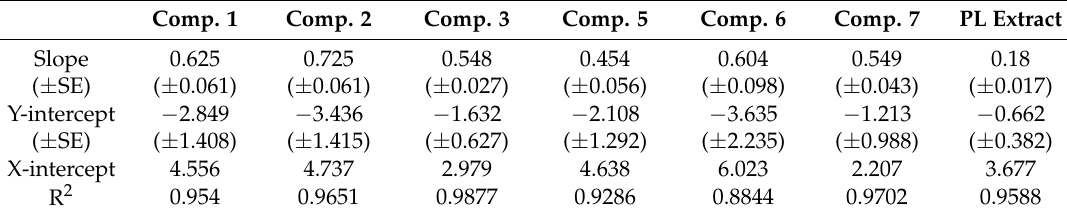
Table 5. Regression parameters and goodness of fit data for the in vitro dissolution study of PL-SNEDDS compositions based on the determination of DPPH radical scavenging activity (see: Figure 5b). SE = Standard Error, (Comp. = Composition).